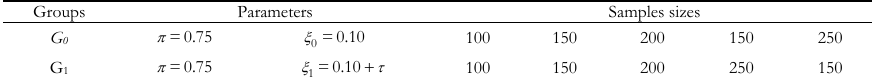
Design of the simulation